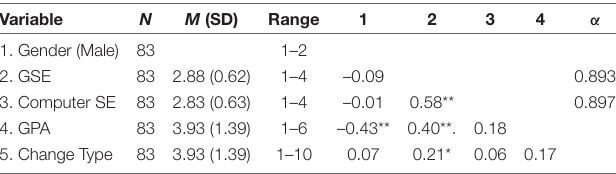
TABLE 3 | Means, standard deviations, range, bivariate correlations, and Cronbach’s alphas of predictor and dependent variables. Variable